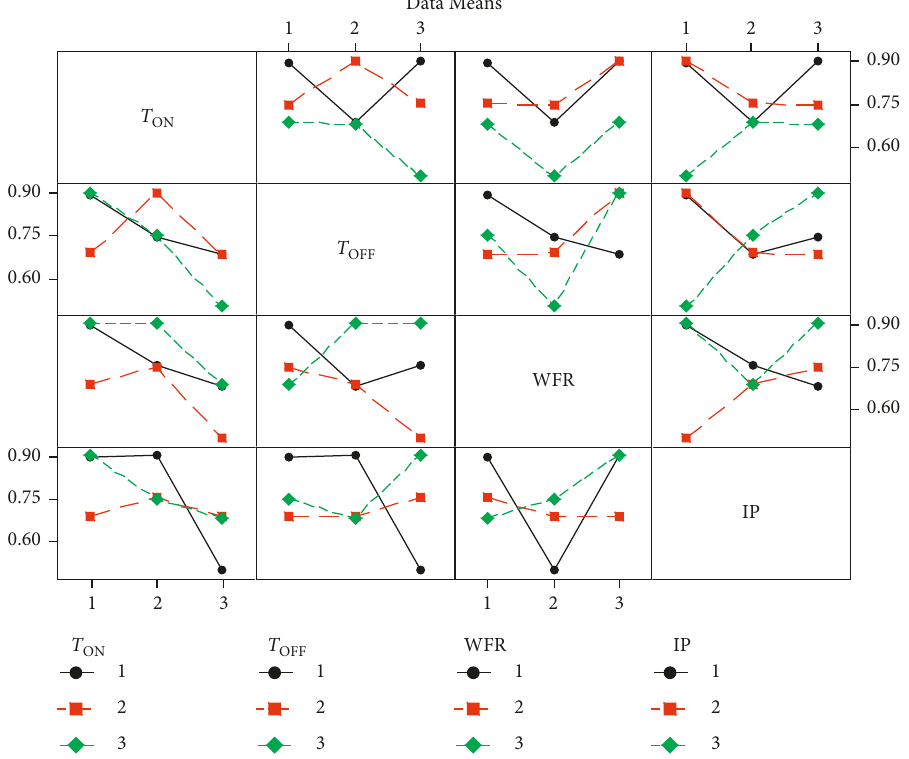
Figure 14: Interaction plot for GFRG.